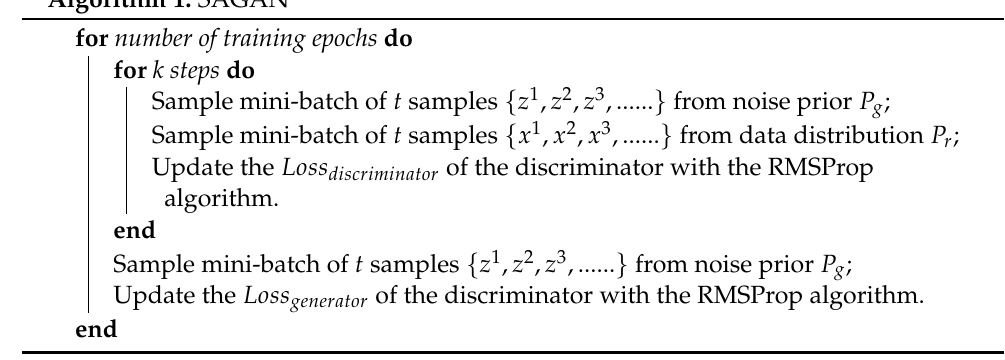
Algorithm 1: SAGAN